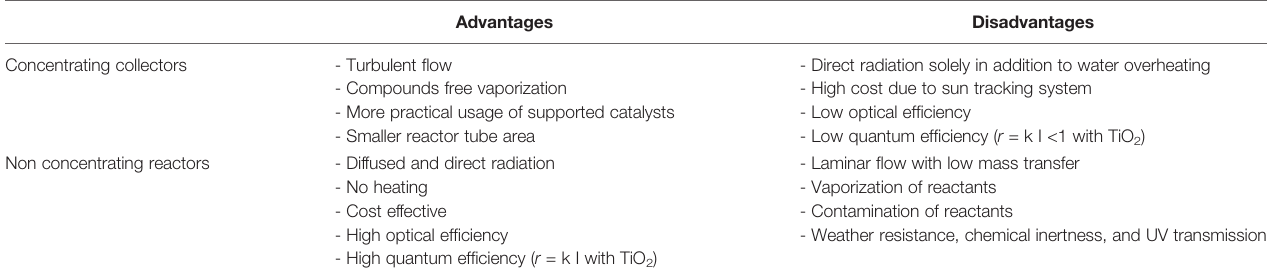
TABLE 4 | Comparisons between parabolic and non-concentrating solar